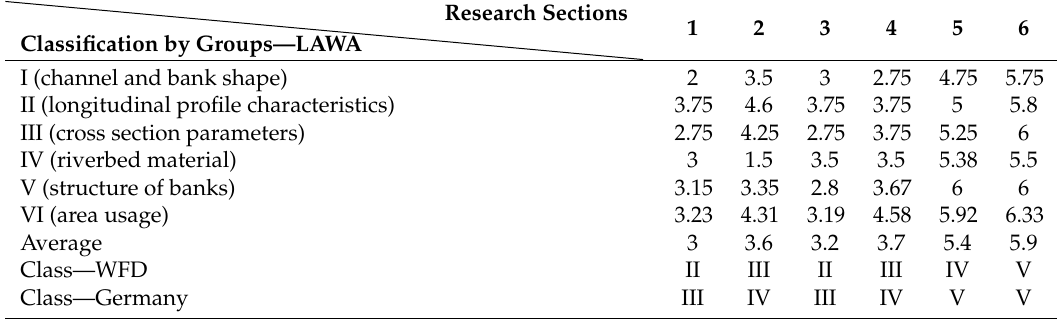
Table 8. Results of the hydromorphological status testing in the research sections under analysis based on the LAWA method.